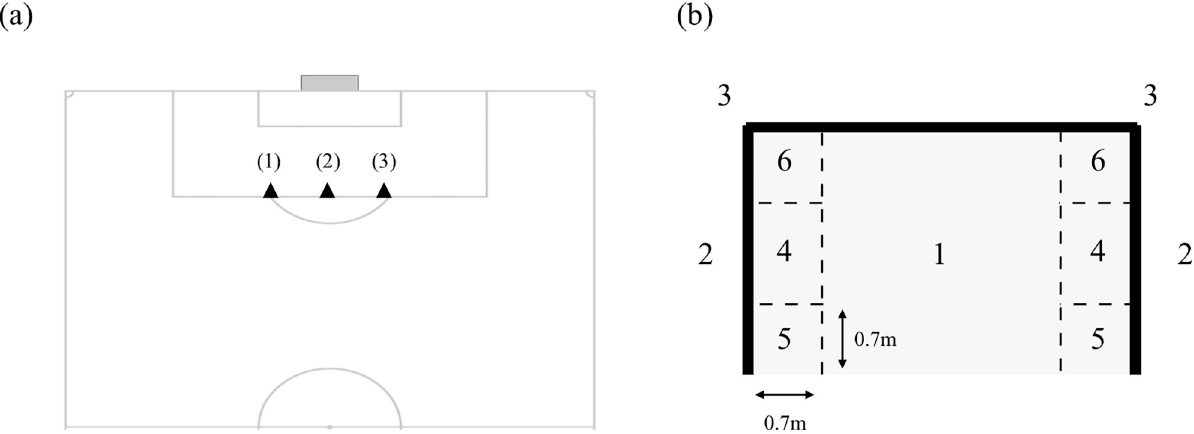
Fig 2. Representation of kicking accuracy task: a) field locations used in the kicking accuracy task; b) illustration of the scoring system used in the kicking accuracy task. The football goal was divided into 7 scoring zones. A score of 1 was attributed to a ball entering through the centre of the goal. A score of 2 was allotted to ball striking the frame of the goal (post & cross bar). A score of 3 was given to a ball striking the junction between post and cross bar. A score of 4 was given to a ball entering through a middle section of the goal. Scores of 5 and 6 were attributed to balls entering the bottom and top corners of the goal, respectively. Scoring areas were divided using a 0.7 m distance from the top and bottom of the goals, as well as a 0.7 m distance from the from each corner of the